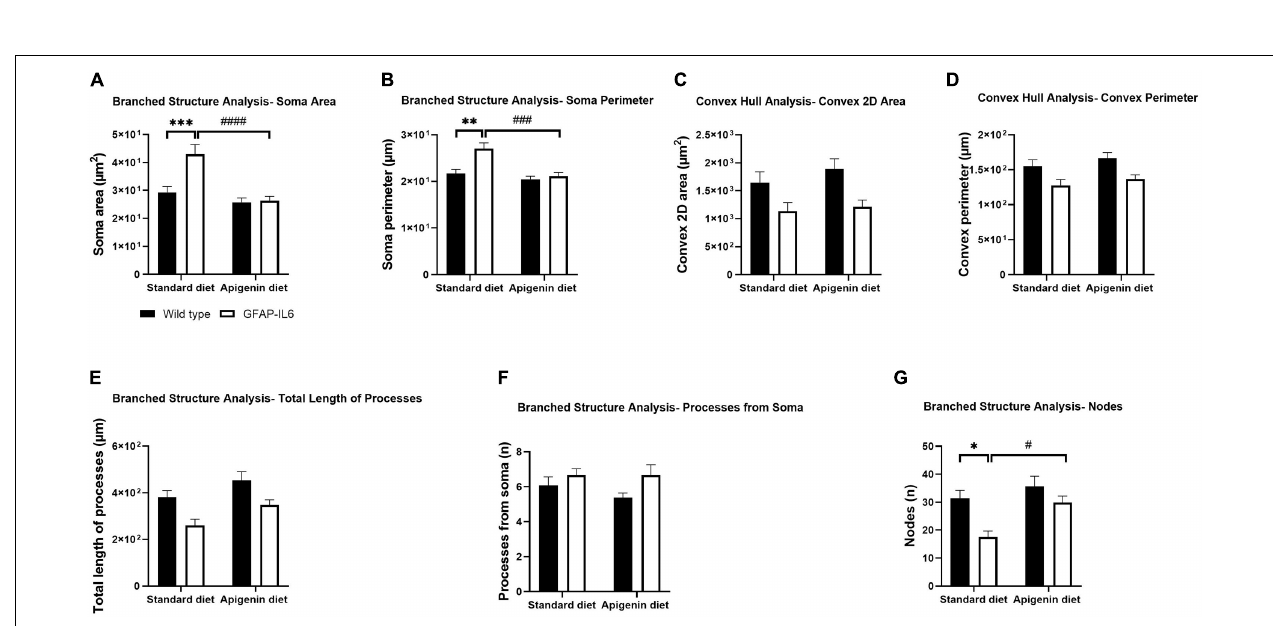
FIGURE 4 | Effects of apigenin diet on Iba-1 + microglial cell morphology in the hippocampus. Quantitative analysis of the morphological changes in Iba-1 + microglia, including (A) soma area ( µ m 2 ), (B) soma perimeter ( µ m), (C) convex 2D area ( µ m 2 ), (D) convex perimeter ( µ m), (E) process length ( µ m), (F) number of processes from soma (n), and (G) number of nodes (n). Data presented as mean ± SEM and analyzed with two-way ANOVA followed by Bonferroni post hoc tests. Post hoc effects of “genotype” are represented in asterisks ( ∗ p < 0.05, ∗∗ p < 0.01, ∗∗∗ p < 0.001, **** p < 0.0001); post hoc effects of “diet” are represented by hash symbols ( # p < 0.05, ## p < 0.01, ### p < 0.001, #### p < 0.0001).